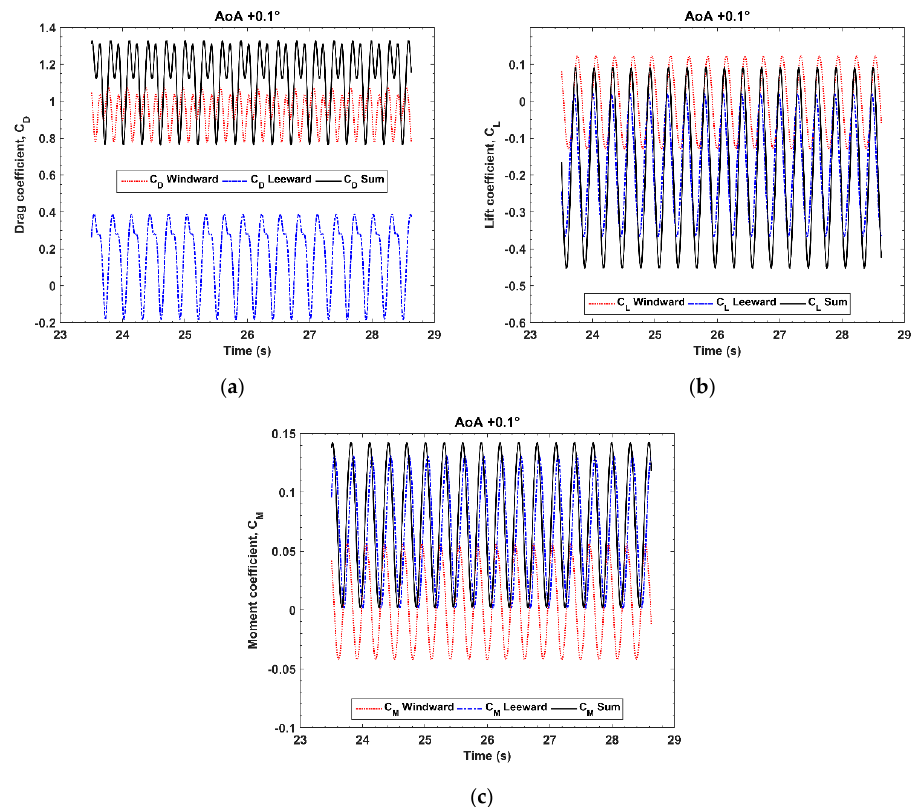
Figure 8. Time histories of force coefficients (AoA = +0.1°): ( a ) drag coefficient, ( b ) lift coefficient and ( c ) moment coefficient. ( c ) moment coe ffi